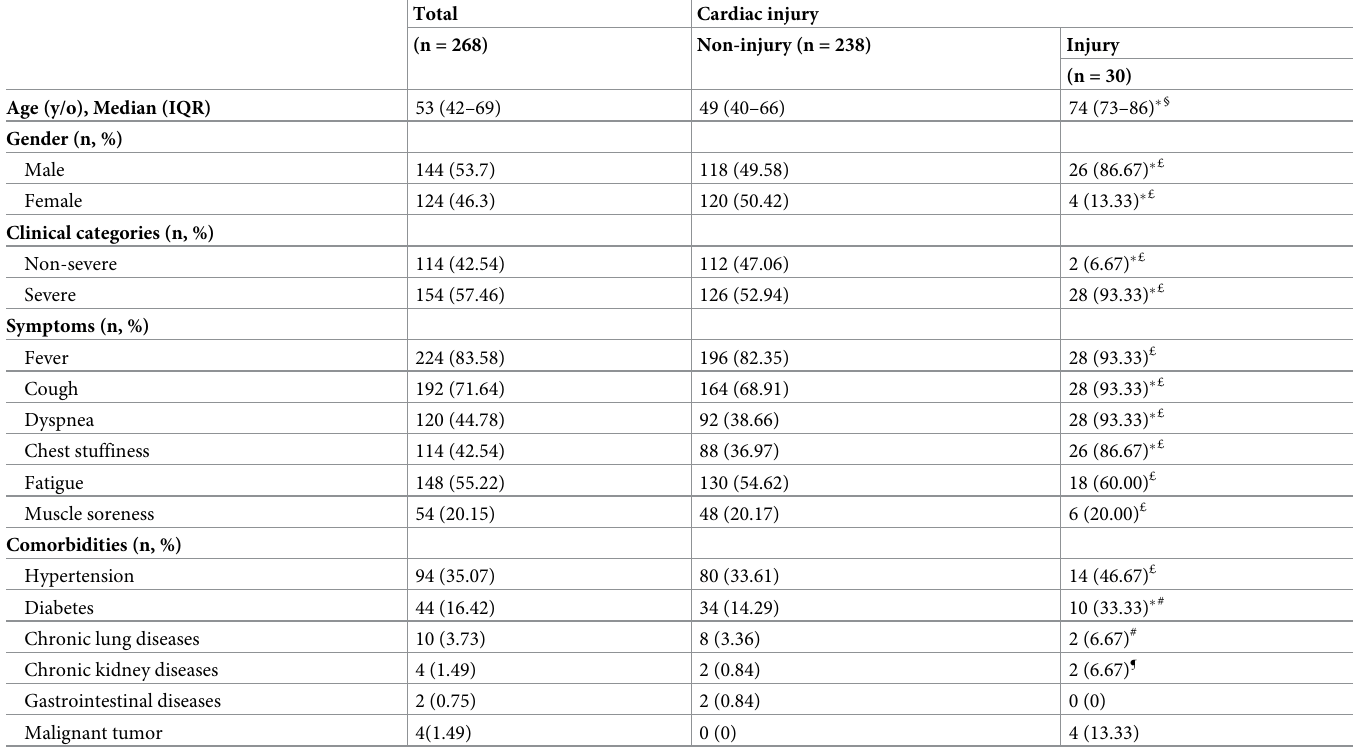
Table 1. Clinical characteristics of COVID-19 patients with or without cardiac injury.